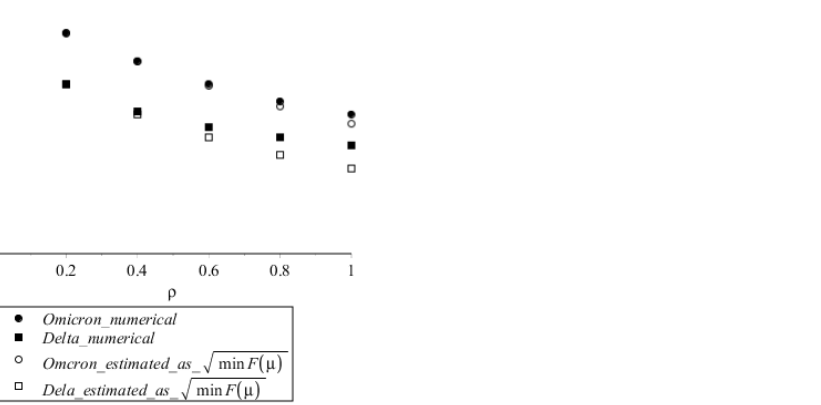
Figure 6. Steady autowave speed as a function of ρ , assuming that ρ can vary continuously (see Table 1 for other model parameters). Speed values for ρ = 1 and ρ = 0 are presented in Table